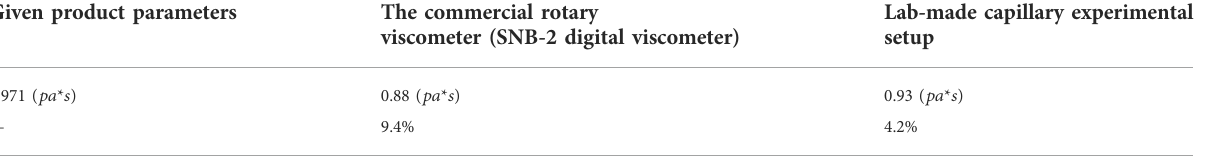
Table 3; Four magnetic fi elds with intensities 6, 13, 20 and 25 mT are selected for testing.